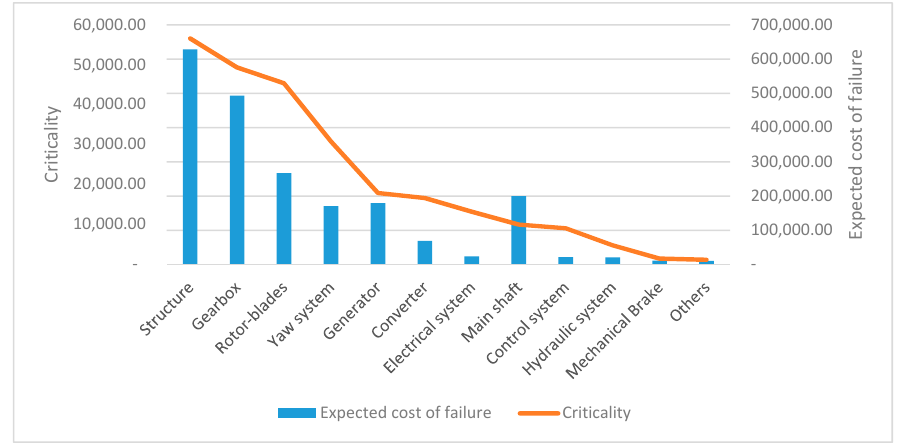
Figure 6. Expected costs of failure and criticality for wind turbine sub-systems.